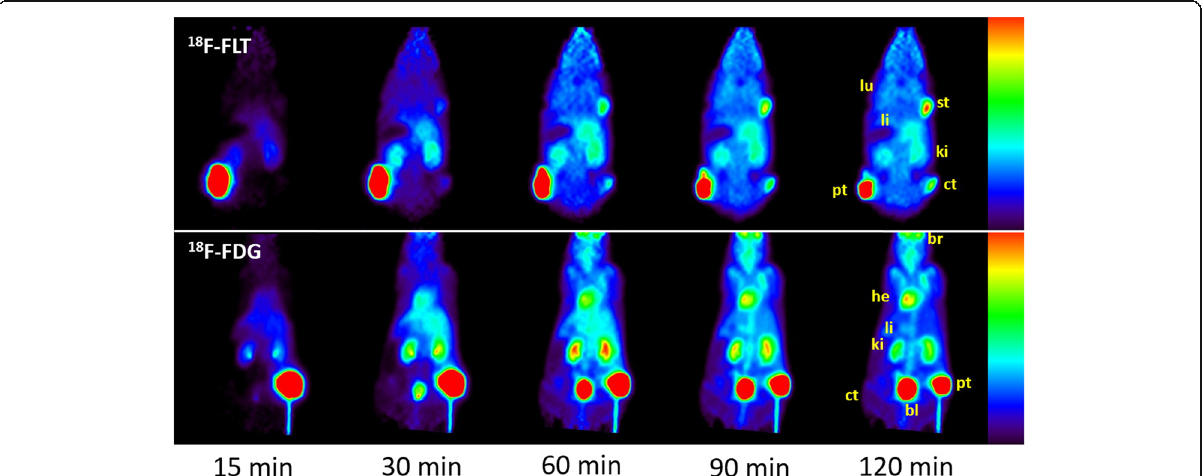
Fig. 1 Kinetics of 18 F-FLT (top) and 18 F-FDG (bottom) distribution up to 120 min after i.t infusion of 5 MBq in the primary tumor (pt) of nude mice bearing the colorectal HCT116 tumor as assessed by PET imaging. Tumors were implanted on each thigh and additionally on the right shoulder solely for animals injected with 18 F-FLT. 18 F-FLT uptake increased steadily in the distant contralateral (ct) and shoulder tumors (st) as it decreased in the i.t. injected tumor, in contrast to 18 F-FDG that mostly diffused in the heart (he), brain (br), and kidneys (ki). Lower accumulation in healthy tissues was obtained with i.t. 18 F-FLT. lu denotes the lung and li denotes the